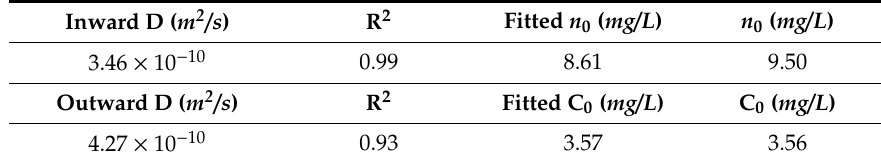
Table 6. Fitting result of inward and outward di ff usion when treating boundary and initial conditions as